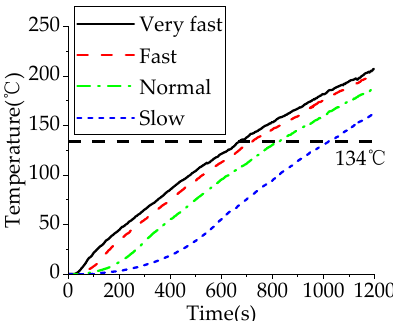
Figure 14. Temperature of the weld joint above the fire.